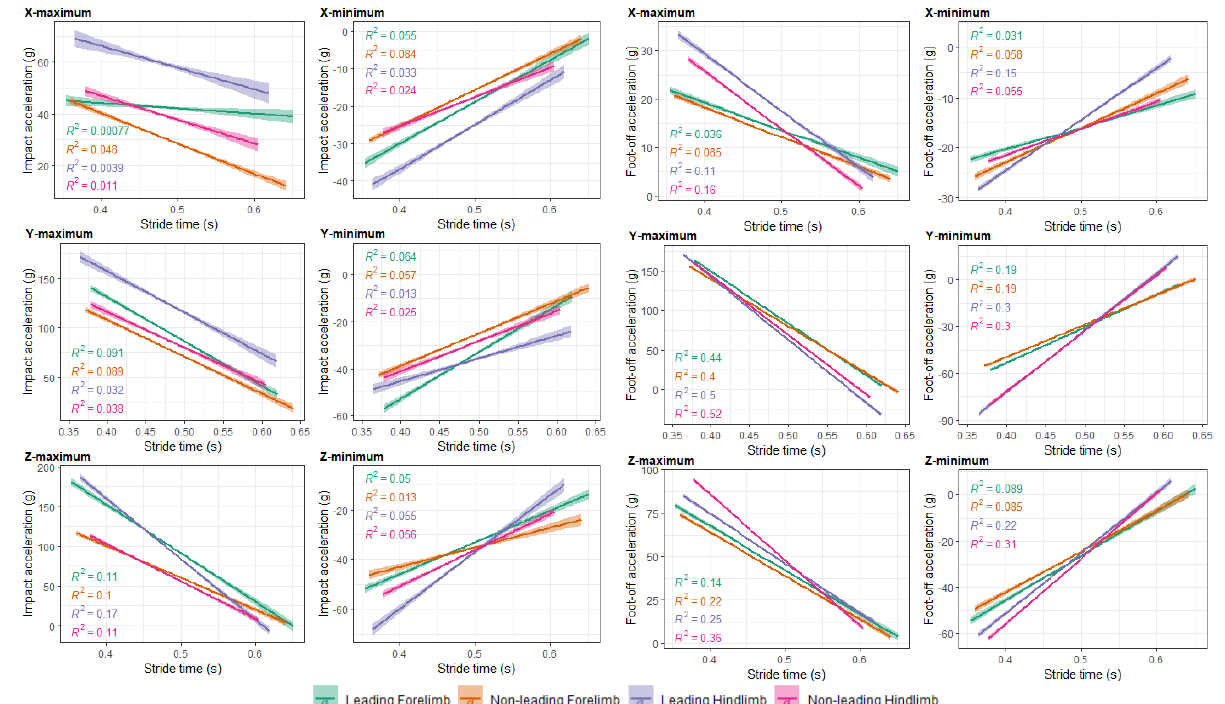
Figure A4. Relationship between stride time and the impact and foot-off accelerations. Data are subdivided according to acceleration parameter for each limb. The r 2 and p values for the linear regressions are indicated on the subplots. The shaded areas represent the 95% confidence intervals for predictions from a linear model. All p <